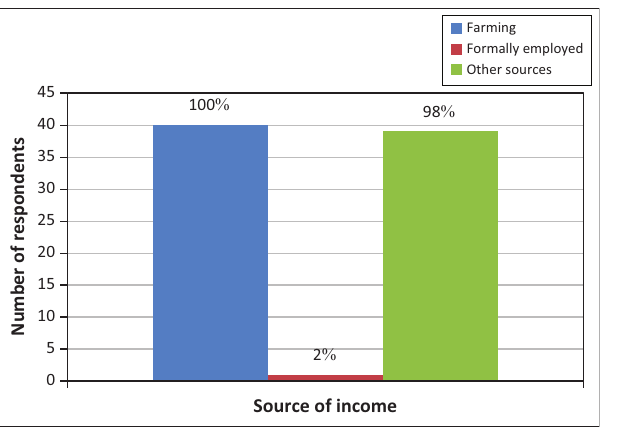
FIGURE 6: Sources of household